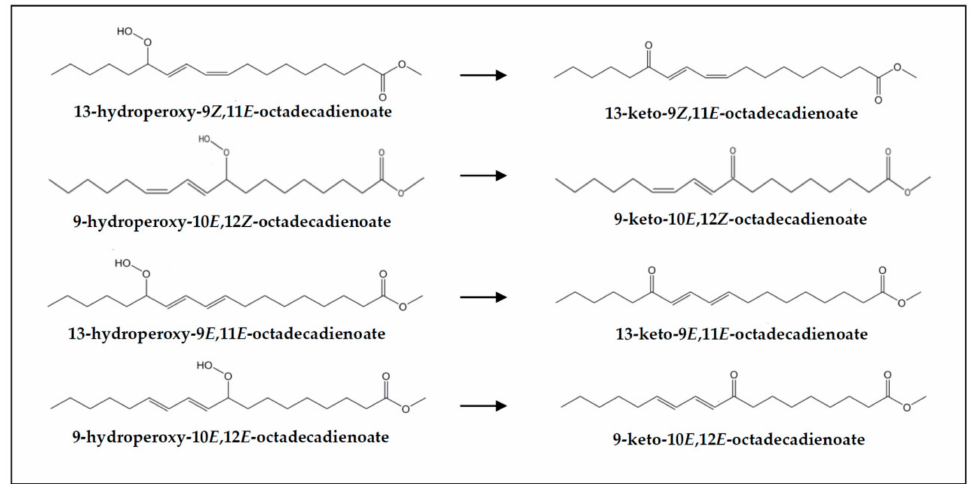
Figure 7. Keto-( Z , E )- and -( E , E )-conjugated octadecadienoates derived from their corresponding precursors monohydroperoxy-( Z , E )- and -( E , E )-conjugated octadecadienoates. (f) Concerning aldehydes . As can be observed in Table 3 and Figure 3a, most of the aldehydes found in the digestates DVSX and DRSX are the same as those detected before in the undigested samples VSX and RSX. Exceptions are ( Z )-2-alkenals and 4-oxo-( E )-2- alkenals, which were only detected in the undigested samples (signals “o” and “n” in Figure